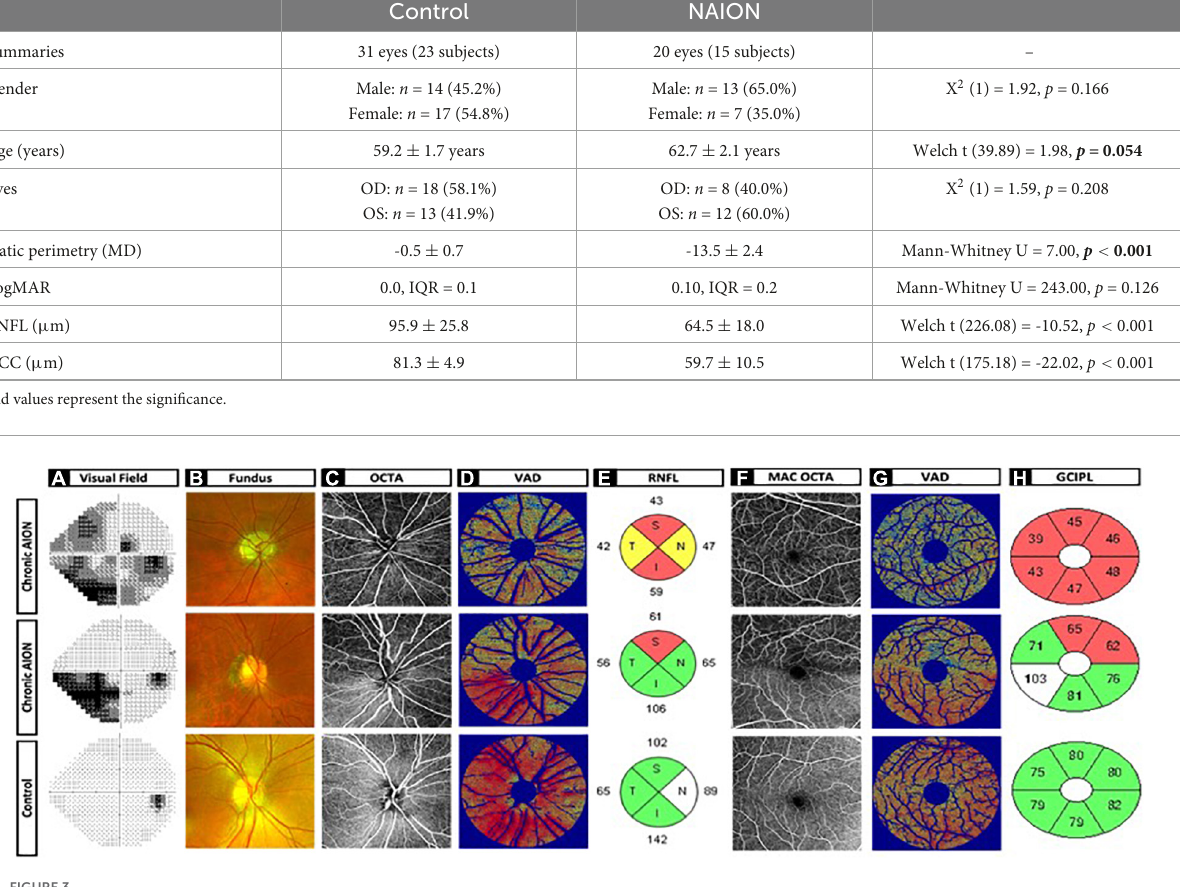
FIGURE3 Chronic non-arteritic anterior ischemic optic neuropathy (NAION) optic disk and macula images and heatmaps versus control. (A) Humphrey visual field. (B) Fundus imaging. (C) OCTA optic disk 6 × 6 original image. (D) Vessel area density heatmap of optic disk. (E) Retinal nerve fiber layer quadrants. (F) OCTA macula 6x6 original image. (G) Vessel area density heatmap of macula. (H) Ganglion cell complex inner plexiform layer sectors. Row 1: Patient 1 is a representative 63-year-old woman with generalized visual field loss mean deviation (MD –14.94 dB), generalized thinning of retinal nerve fiber layer (RNFL), and ganglion cell complex (GCC) (48 and 45 mm, respectively), and diffuse vascular dropout in the peripapillary and macular SCP. Row 2: Patient 2 is a 69-year-old woman with inferior altitudinal moderate visual field loss (MD –10.90 dB), superior thinning of RNFL and GCC (72 and 76 mm, respectively), and superior drop out of peripapillary ( Figure 2B , middle row) and macular SCP vasculature. Row 3: Patient 3 is a 58-year-old woman as the representative control patient with no visual field loss (MD 0.08 dB), no thinning of RNFL and GCC (100 and 79 mm, respectively), and dense peripapillary and macular microvasculature with no vessel dropout.